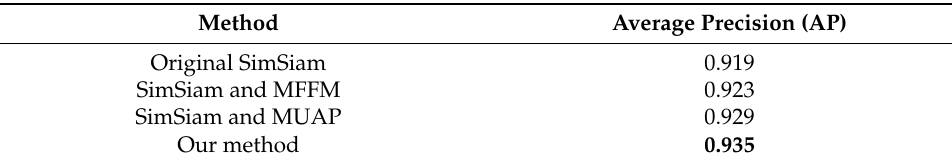
Table 2. Ship detection results (AP) of different pre-training methods.